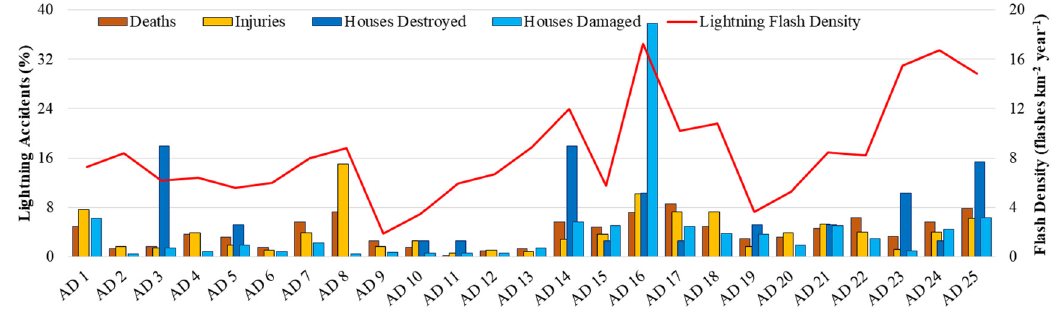
Figure 5. Variations of the lightning accidents in all 25 administrative districts (ADs) in Sri Lanka, from 1974 to 2019. Table 3. Recorded number of lightning accidents in each administrative district, from 1974 to 2019.